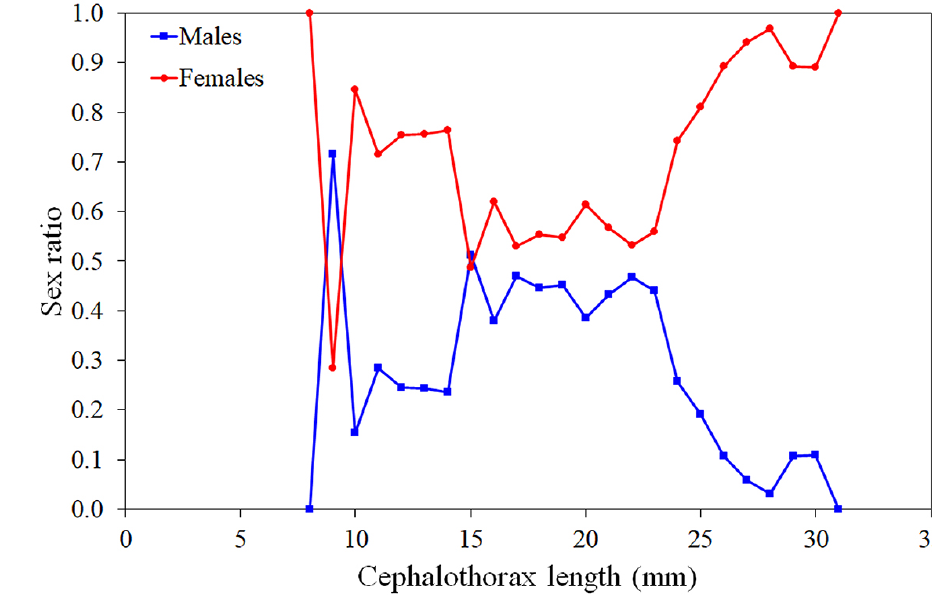
Figure 6. Sex ratio of Plesionika edwardsii by size class in the Azorean region during the period